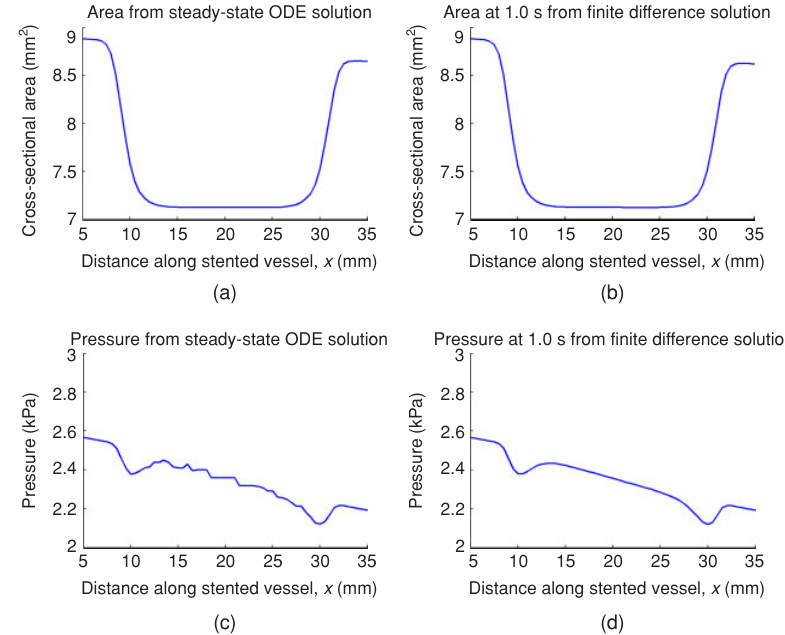
Figure 6 Area and pressure from steady-state ODE solution ((a) and (c)) and from finite difference solution at a simulation time of 1.0 s ((b) and (d)). The steady-state ODE solution does not appear as smooth as the finite difference solution due to numerical errors introduced by the ODE